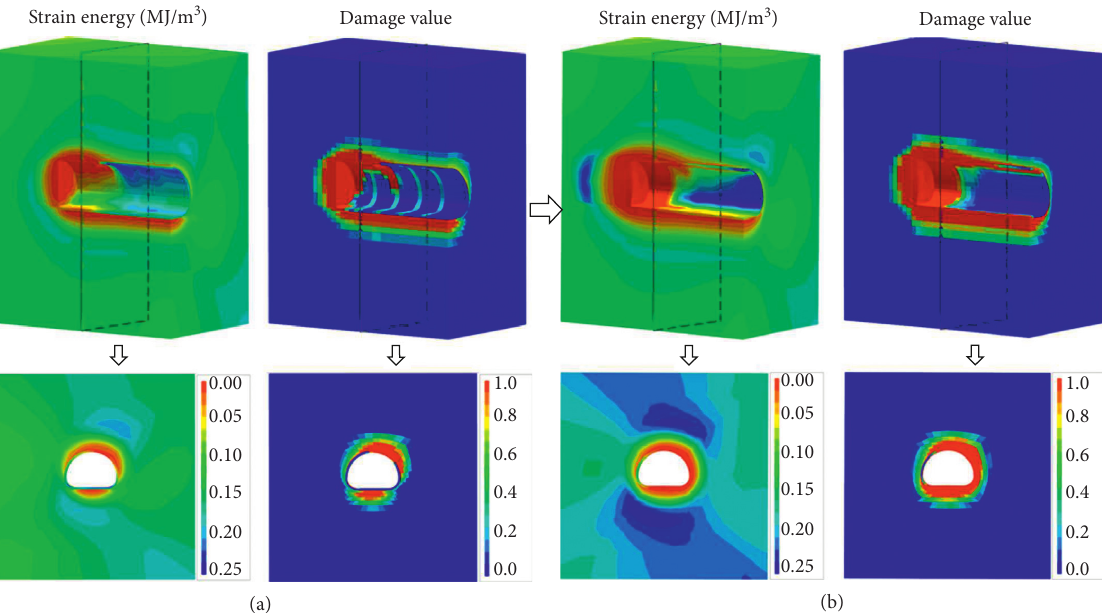
Figure 11: Simulation and comparison of rockburst effect (continuous model): (a) weak support stiffness; (b) strong support